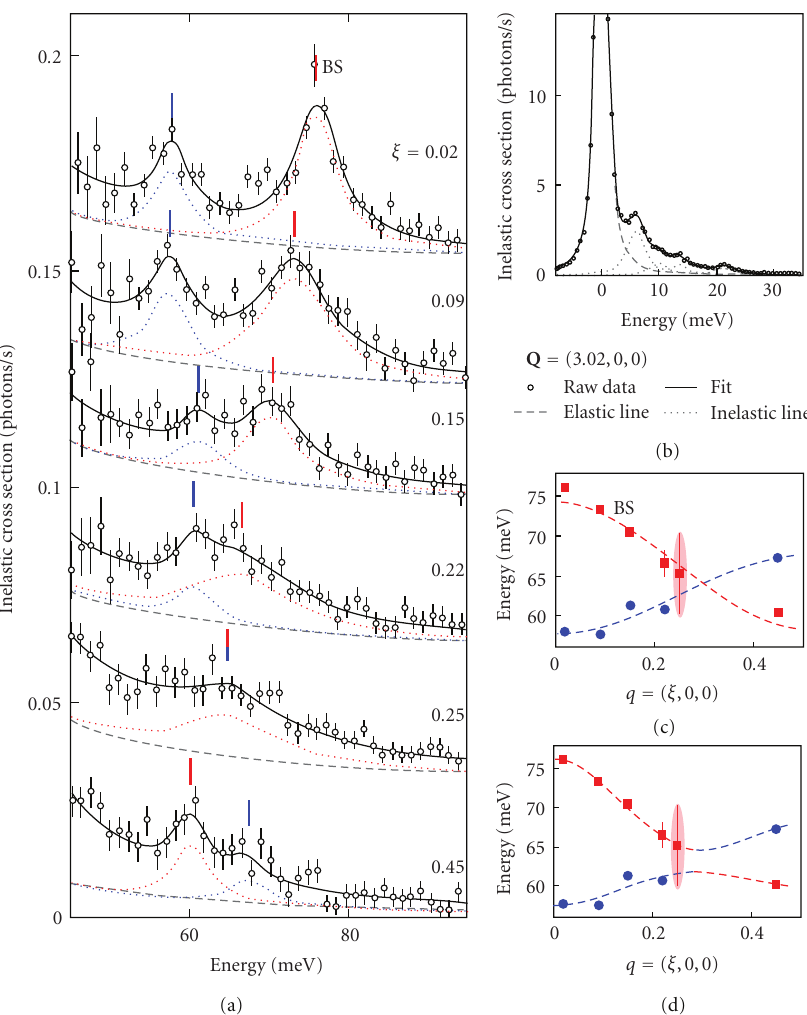
Figure 16: (a-b) Raw IXS phonon spectrum taken from optimally doped La-Bi2201 at 10 K. (a) Focusing on the high-energy part and the LO phonon dispersions for Q = (3 + ξ , 0, 0) with ξ ranging from the BZ center to the BZ face. (b) Stronger low-energy part of the phonon spectrum. Solid lines indicate fits, dashed lines show the elastic tail, and dotted lines indicate the modes. (c-d) The peaks of these dispersions are plotted with cosine-dashed lines for the two potential dispersion scenarios: crossing (c) and anticrossing (d). The figures taken are from